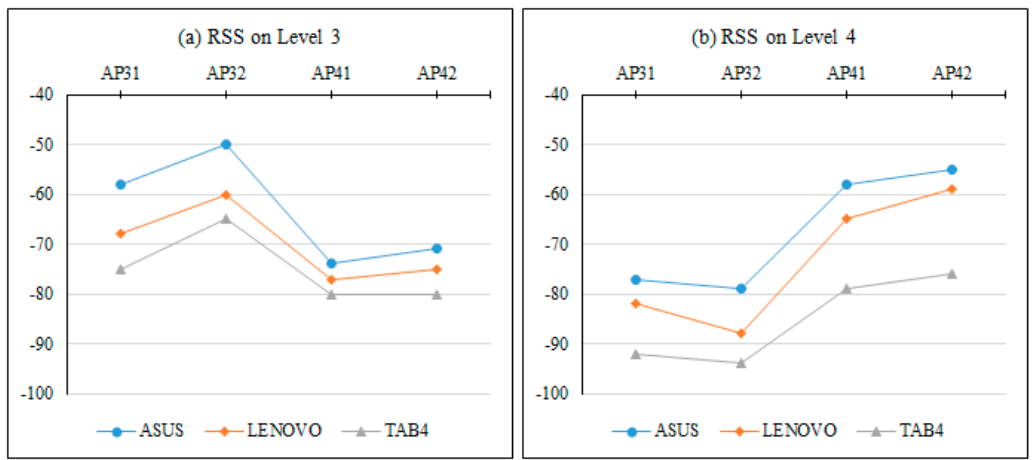
Figure 15. The calibrated RSS differences due to MD heterogeneity in different floors.